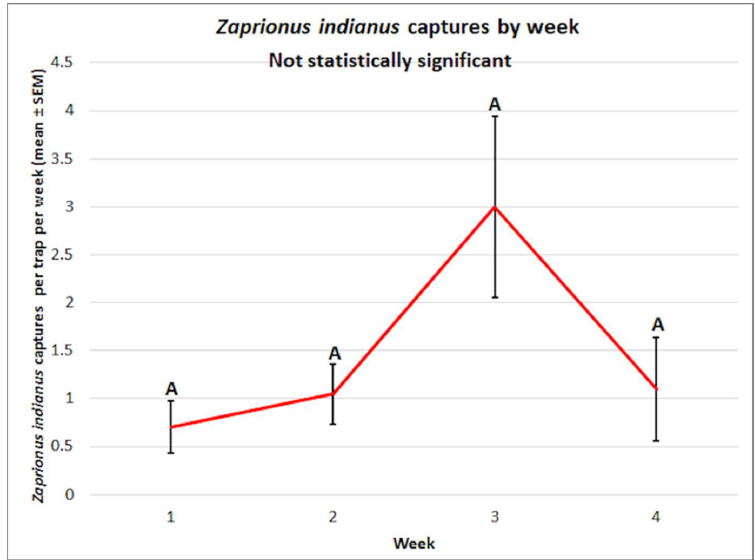
Figure 8. Mean (± SEM) Zaprionus indianus captures by week. Different letters represent statistically significant differences ( p < 0.05, Tukey’s HSD test) between attractant solutions.